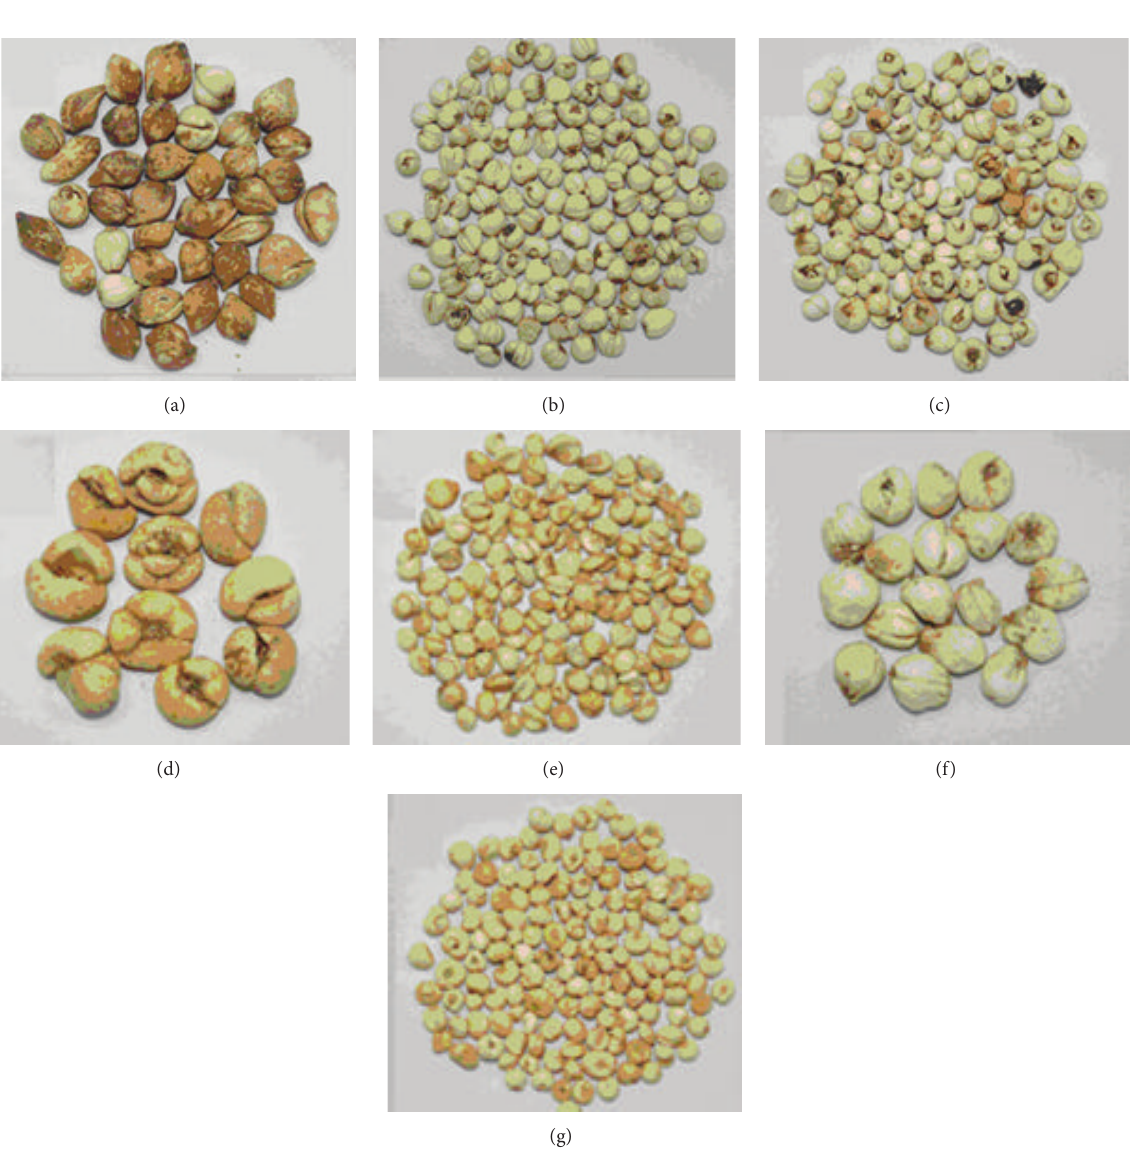
Figure 1: Seven kinds of Fritillaria materials used in China. (a)–(g) were Fritillaria delavayi Franch, F. unibraacteate Hsiao et. K. C. Hsia, F. cirrhosa D. Don, F. thunbergii Miq. (big), F. thunbergii Miq. (small), F. pallidiflora Schrenk, and F. ussuriensis Maxim,